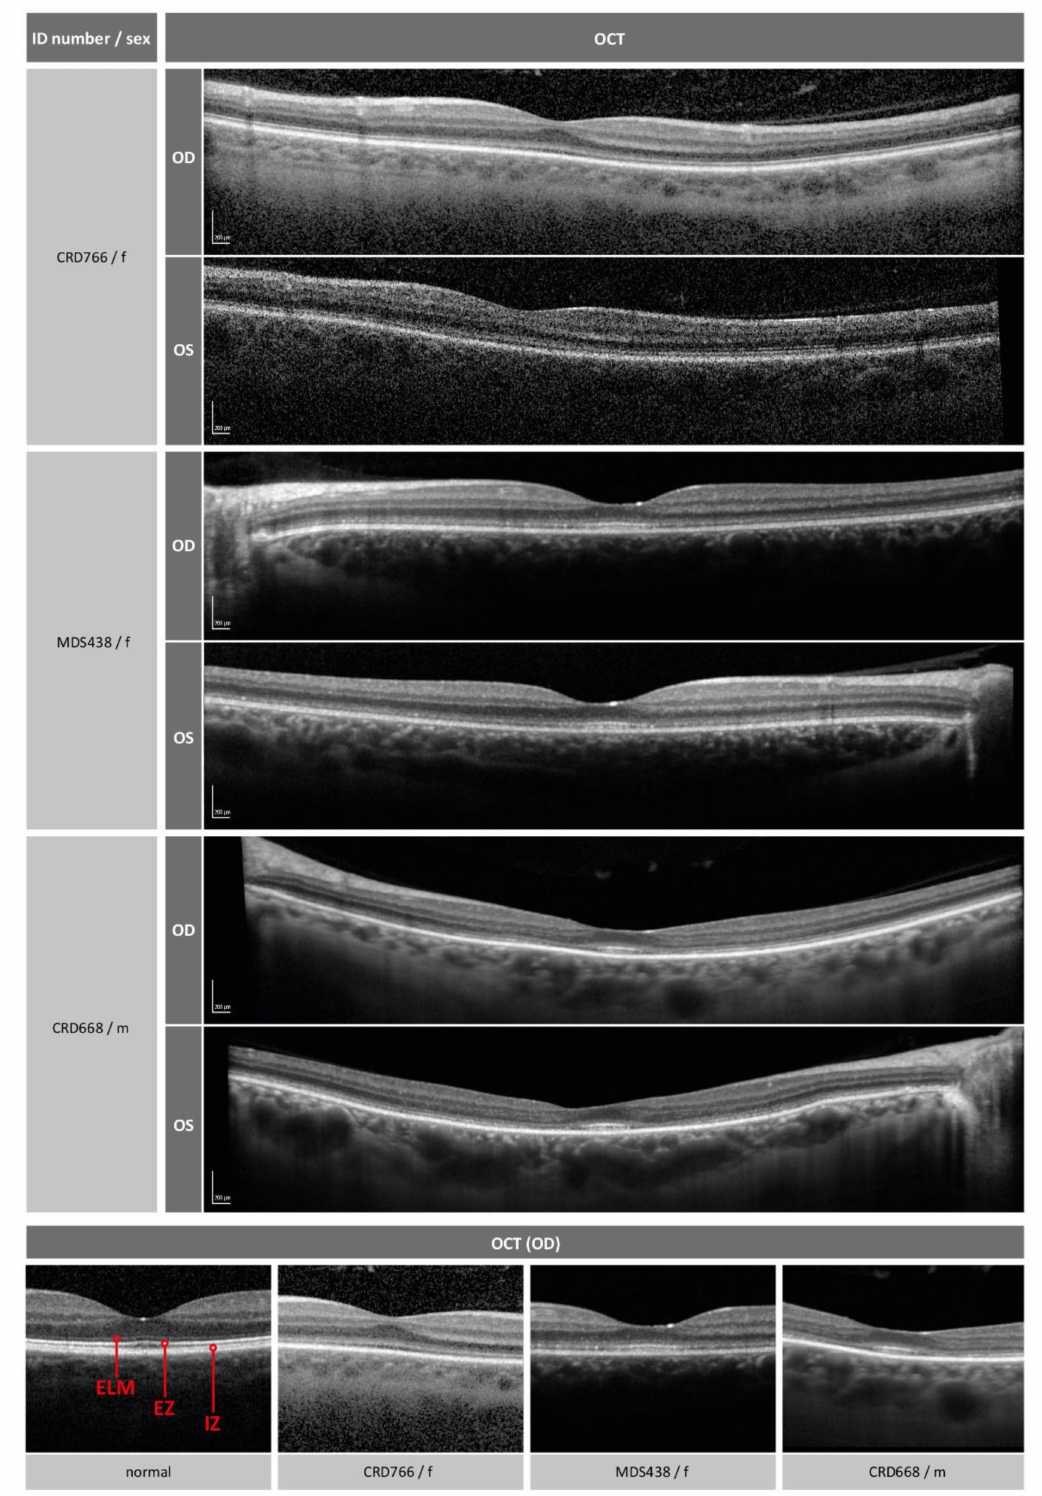
Figure 3. Visualization of retinal layers with optical coherence tomography (OCT). The lower row shows magnifications of the foveal region. For comparison, an example of a normal eye is shown on the left. ELM (external limiting membrane), EZ (ellipsoid zone) and IZ (interdigitation zone, outer segments) are indicated. The foveal region of the patients show diffuse disturbance of the ELM and EZ/IZ layers (CRD766, MDS438) or perifoveal atrophy of the layers with relative foveal sparing (CRD668). OD, right eye; OS, left eye; f, female; m,